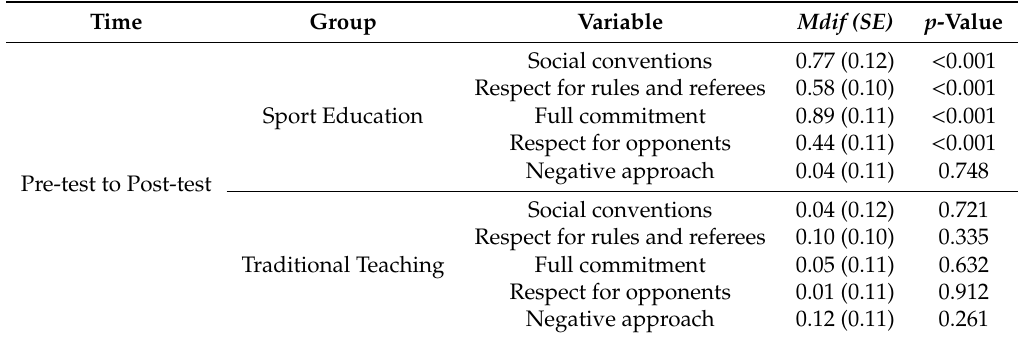
Table 5. Analysis within-group pre-test to post-test di ff erences in sportsmanship orientation scores. Time Group Variable